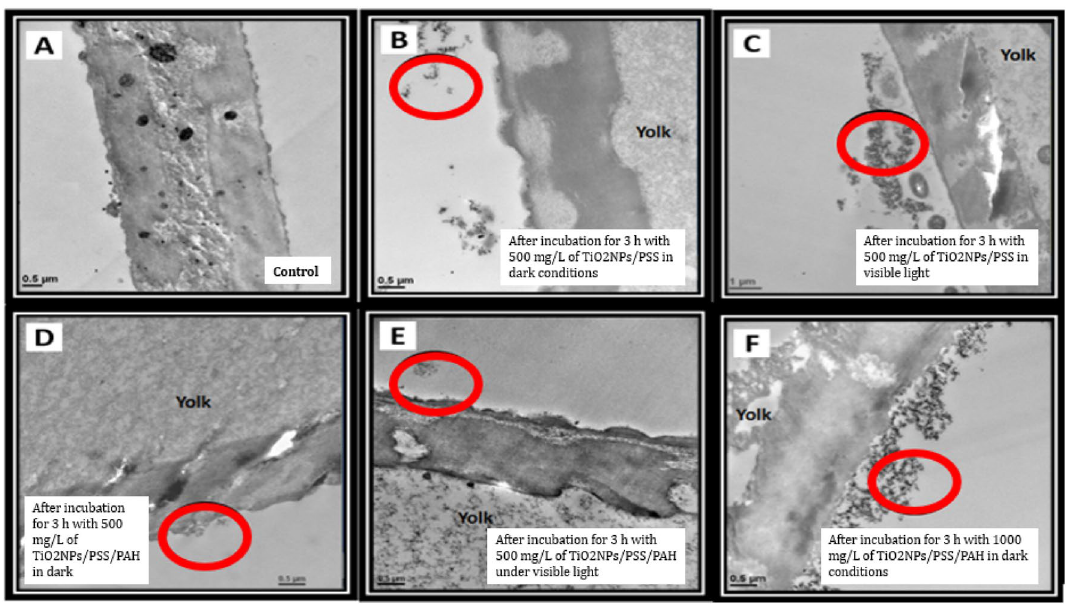
3 h with 500 mg/L of TiO NPs/PSS/PAH under visible light, f after 2 incubation for 3 h with 1000 mg/L of TiO NPs/PSS/PAH in dark con- 2 ditions. The circles represent the areas used for the EDS spectrum analysis